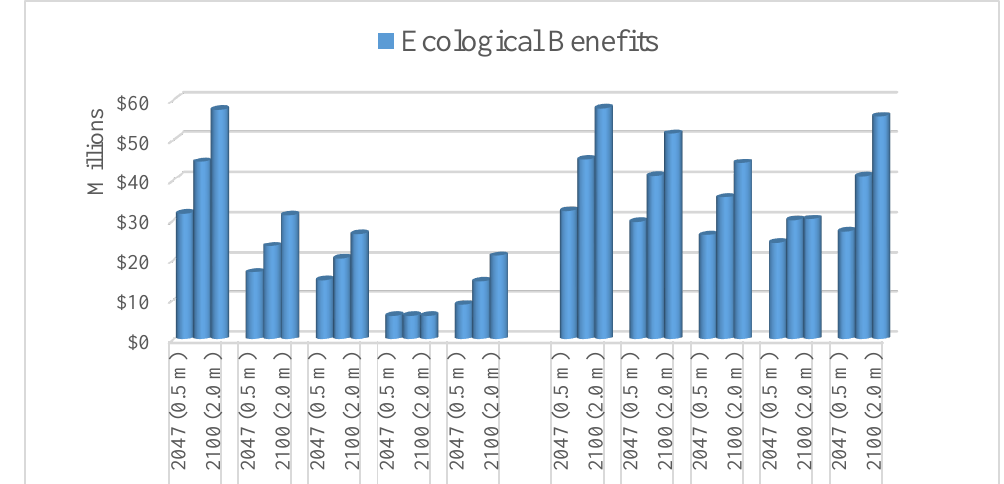
Figure 15. Ecological value of beaches in Imperial Beach using the upland vs. beach width framework coupled with a replacement valuation.